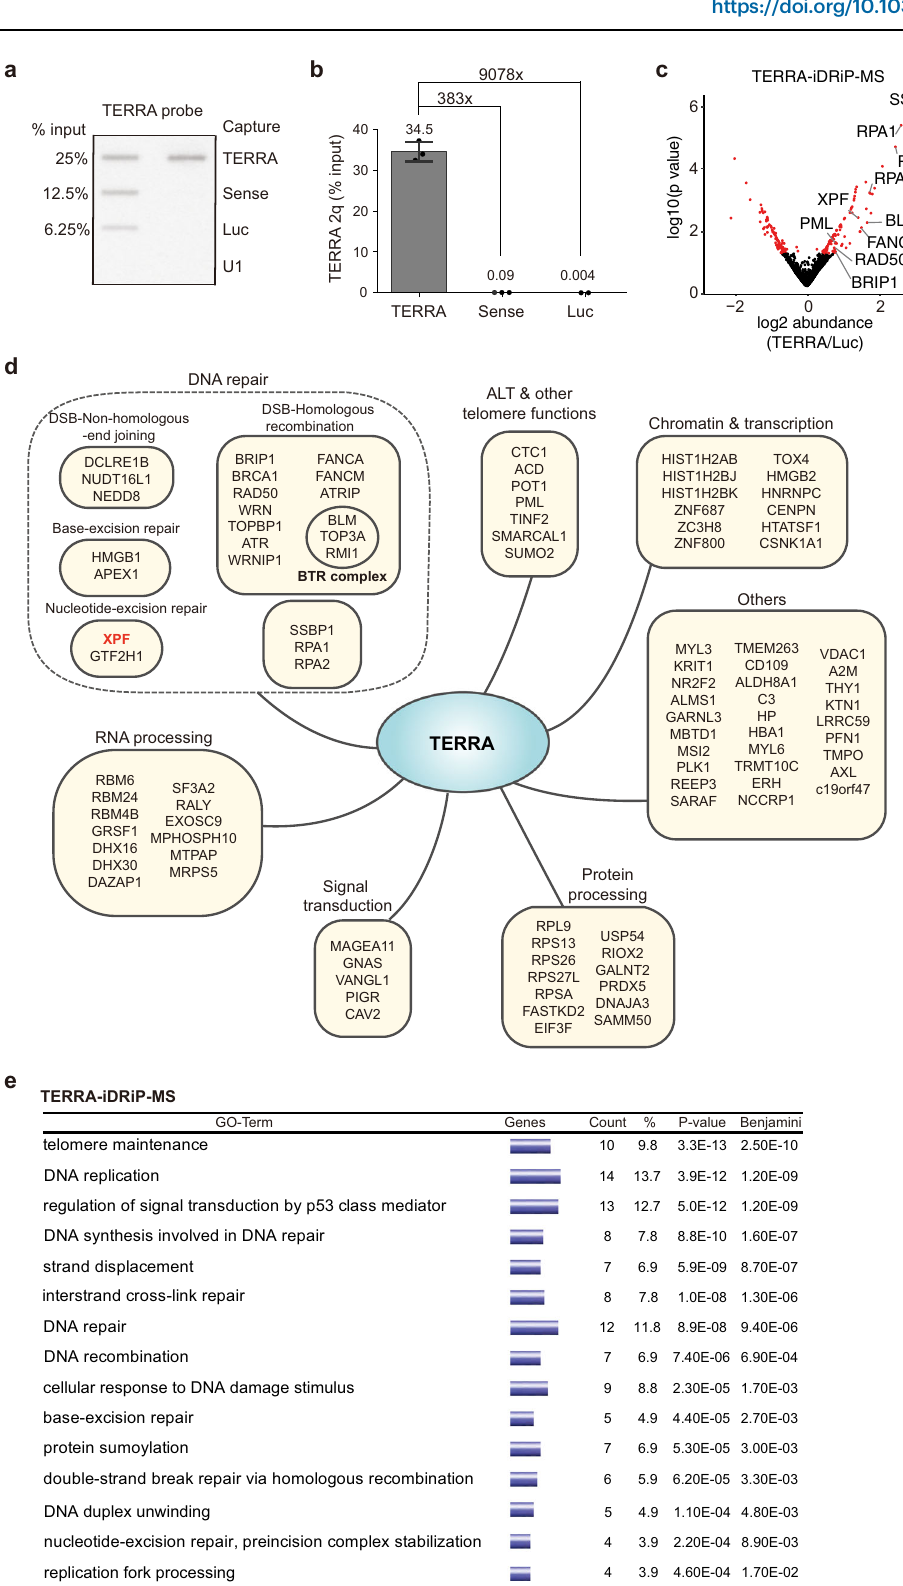
method. d TERRA interacting proteins are subclassi fi ed into functional groups. Data of TERRA-iDRiP-MS enriched proteins from four biological replicates. e Gene Ontology analysis of TERRA interacting proteins identi fi ed enriched pathways by DAVID bioinformatics resources. P -values by Fisher Exact test. Benjamini FDR was